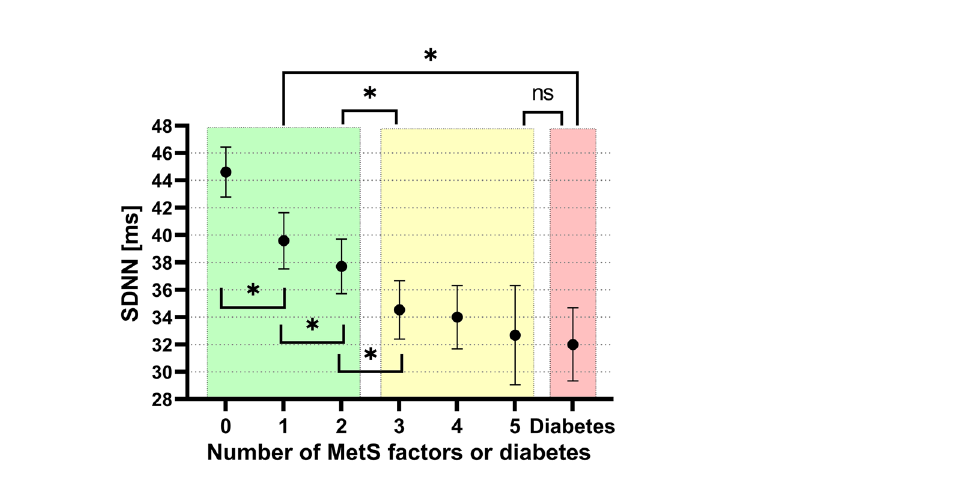
Figure 2. Mean and 95% confidence intervals of SDNN from the pre-CPT period for participants having different numbers of metabolic syndrome components or diabetes. Green area represents healthy subjects and yellow area represents subjects with metabolic syndrome according to current definitions. *p < 0.05 from contrast analysis and Tukey’s tests. Only Tukey tests from adjacent groups are shown in this plot, for a complete overview, see supplementary figure